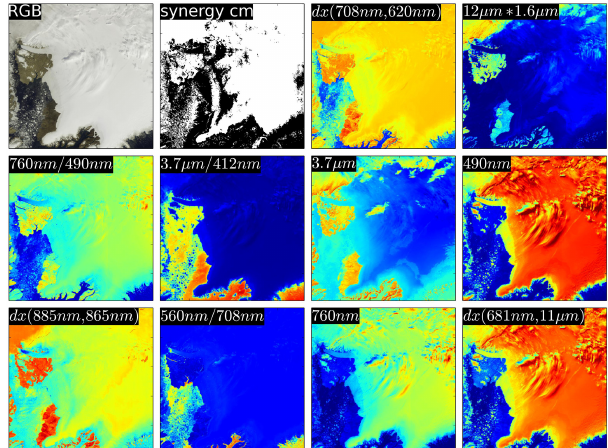
Figure 1. Several views of a scene over Greenland from 17 July 2007 with the image centered at 59 ◦ 31 (cid:48) 12 (cid:48)(cid:48) W and 79 ◦ 0 (cid:48) 0 (cid:48)(cid:48) N. Sin- gle panels include a pseudo RGB view, results of the non-Bayesian Synergy cloud mask (with white indicating clouds; see Sect. 6), as well as single channels and simple functions operating on two chan- nels. The function d x denotes the index function and is defined as d x(a,b) = (a − b)/(a + b) . Units are not shown and the color scales are stretched to maximize the visible contrast.